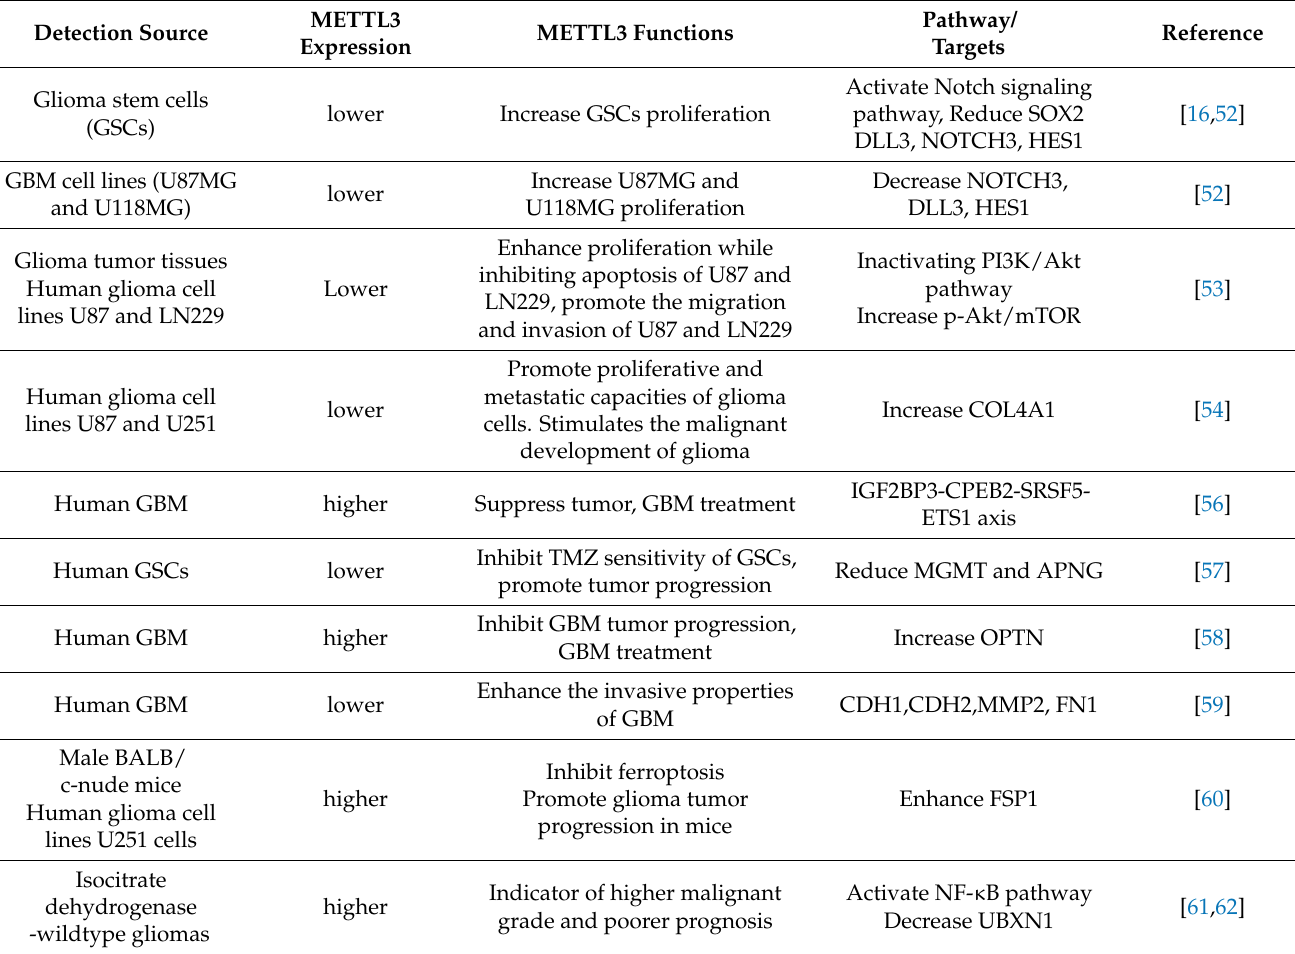
Table 1. Roles and Mechanisms of METTL3 in Brain